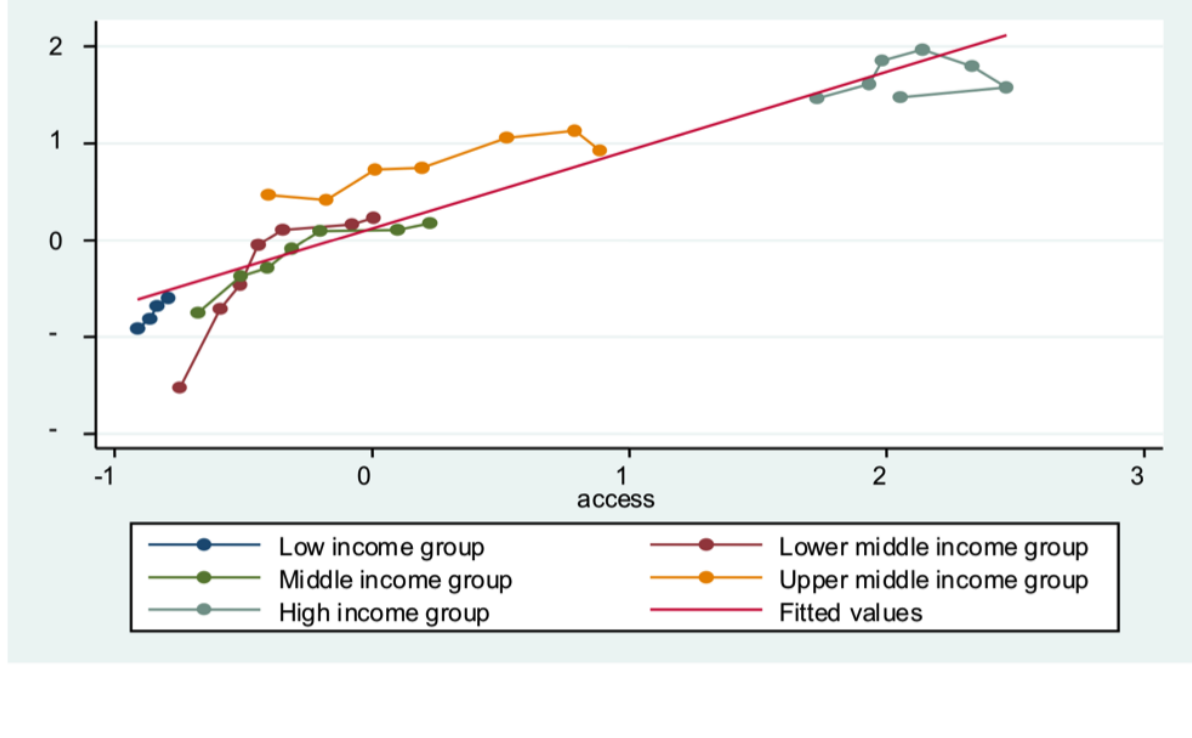
Figure 5. Impact of ICT accessibility on tuberculosis case detection rate.